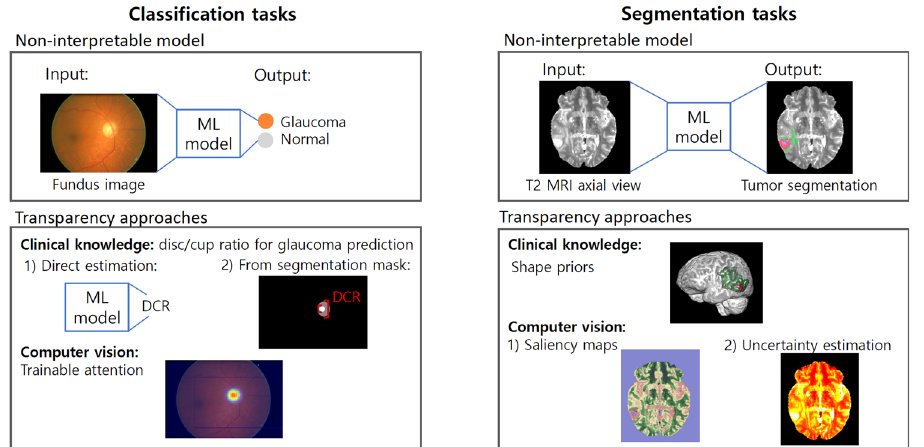
Fig. 2 Illustrative examples of different techniques used in transparent ML systems for classi fi cation and segmentation tasks from the systematic review. Within each task, a non-interpretable model generates the task outcome from the input image (top). The use of clinical knowledge or computer vision information as priors attempts to add transparency in the outcome generation process (bottom). Images retrieved from the ORIGA 127 and BraTS2020 datasets 128